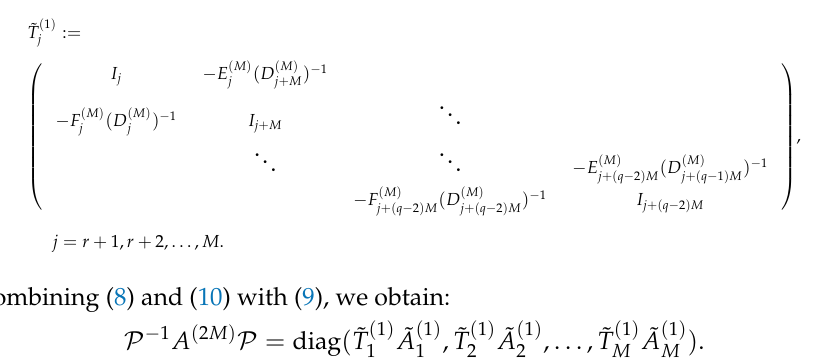
Figure 3 for the relationships among the block tridiagonal (1-tridiagonal), 2-tridiagonal, M -tridiagonal, and 2 M -tridiagonal